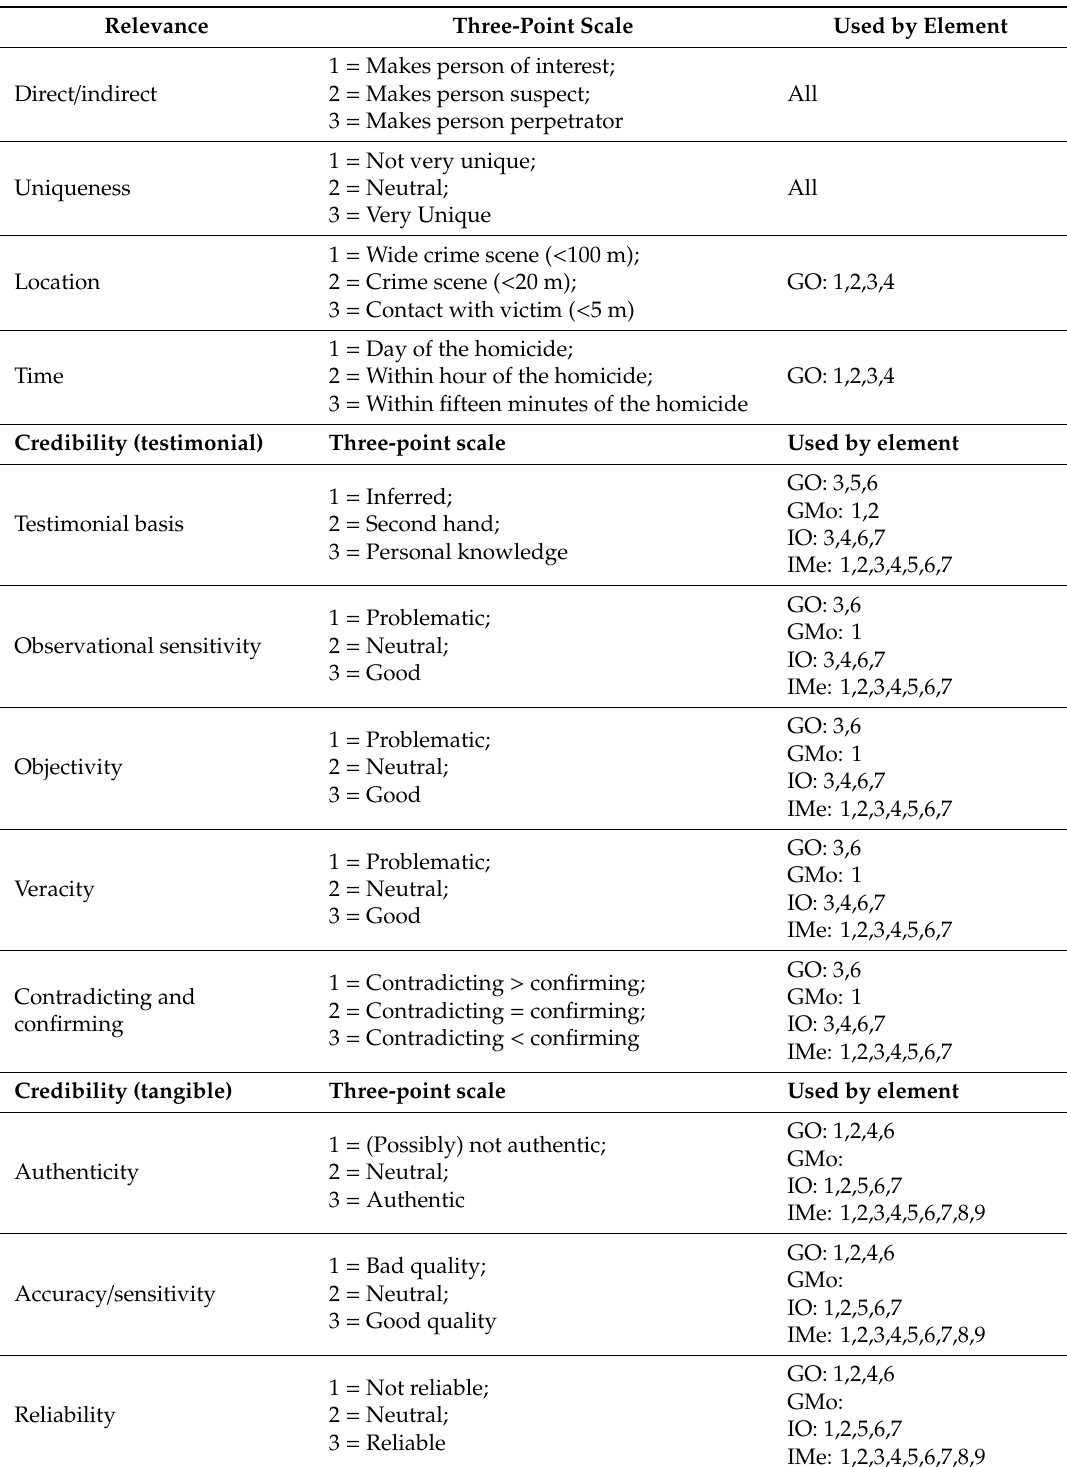
Table 3. The underlying factors of relevance and credibility, the three-point scale to score these factors, and the elements that use the underlying factor are displayed. Relevance Three-Point Scale Used by